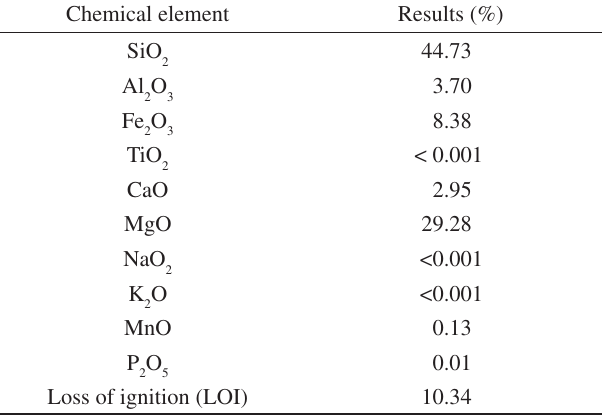
Table 2. Chemical analysis of steatite.